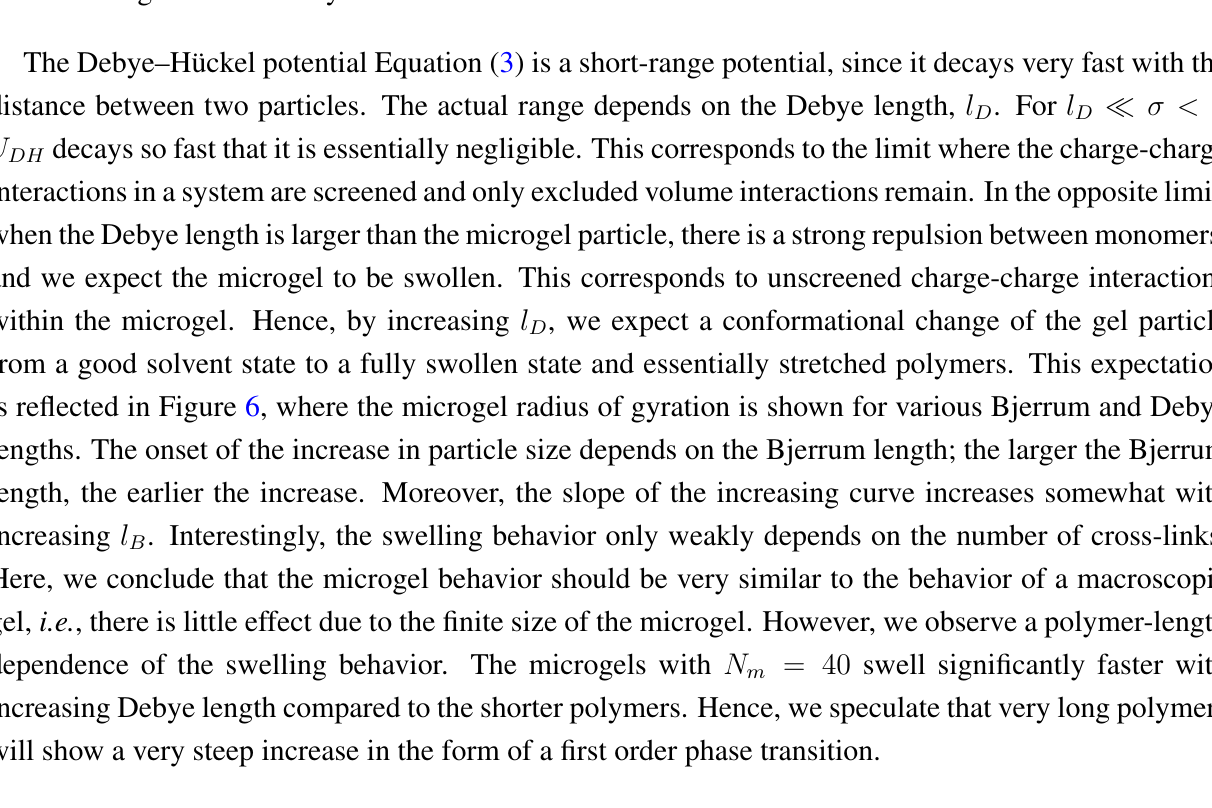
= 40 , N = 729 and p c